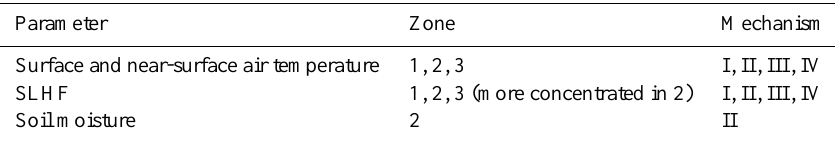
Table 1. The spatial relationship between multi-parameter anomalies and four mechanisms. Zones 1, 2 and 3 are the zones to the northeast of the epicenter, in the center of the North Island, and in the southwestern South Island, respectively. Mechanisms I, II, III, and IV are magmatic-hydrothermal fluids upwelling, soil moisture increasing, underground pore gases leaking, and positive holes activating and recombing, respectively. Zone 2, where the New Zealand earthquake sequence located, is different form Zones 1 and 3 in obvious soil moisture anomaly, which brought with SLHF anomaly more